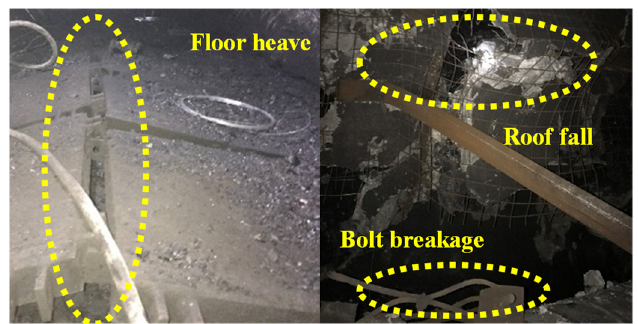
Figure 3. Coal burst characteristics.